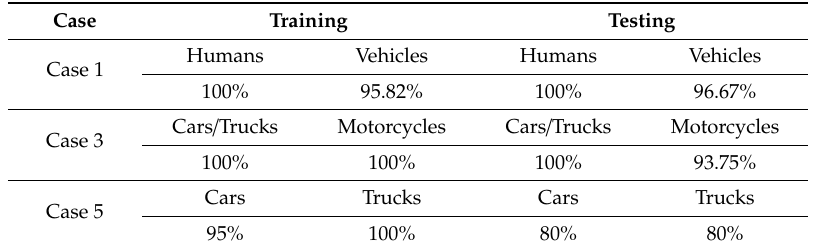
Table 13. Training and testing accuracies for Cases 1, 3, and then 5 as predicted using Rulex before computing the actual accuracies.